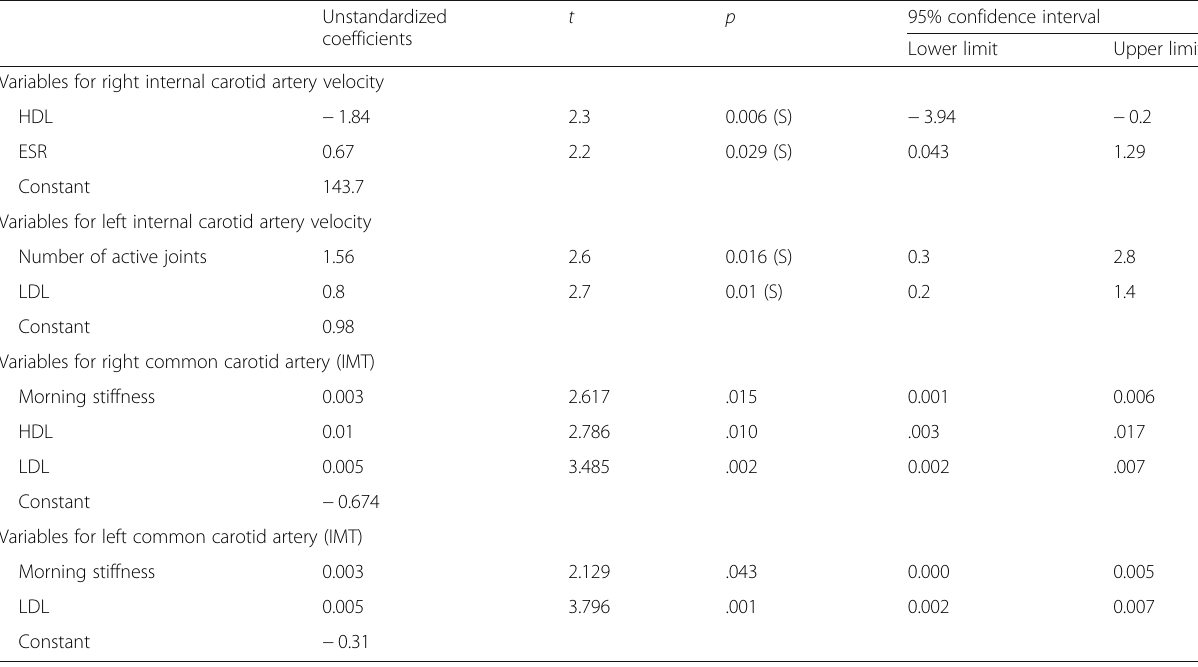
Table 4 Multiple regression analysis to predict risk factors for abnormal right and left internal carotid velocity and right and left common carotid intima-media thickness among juvenile idiopathic arthritis